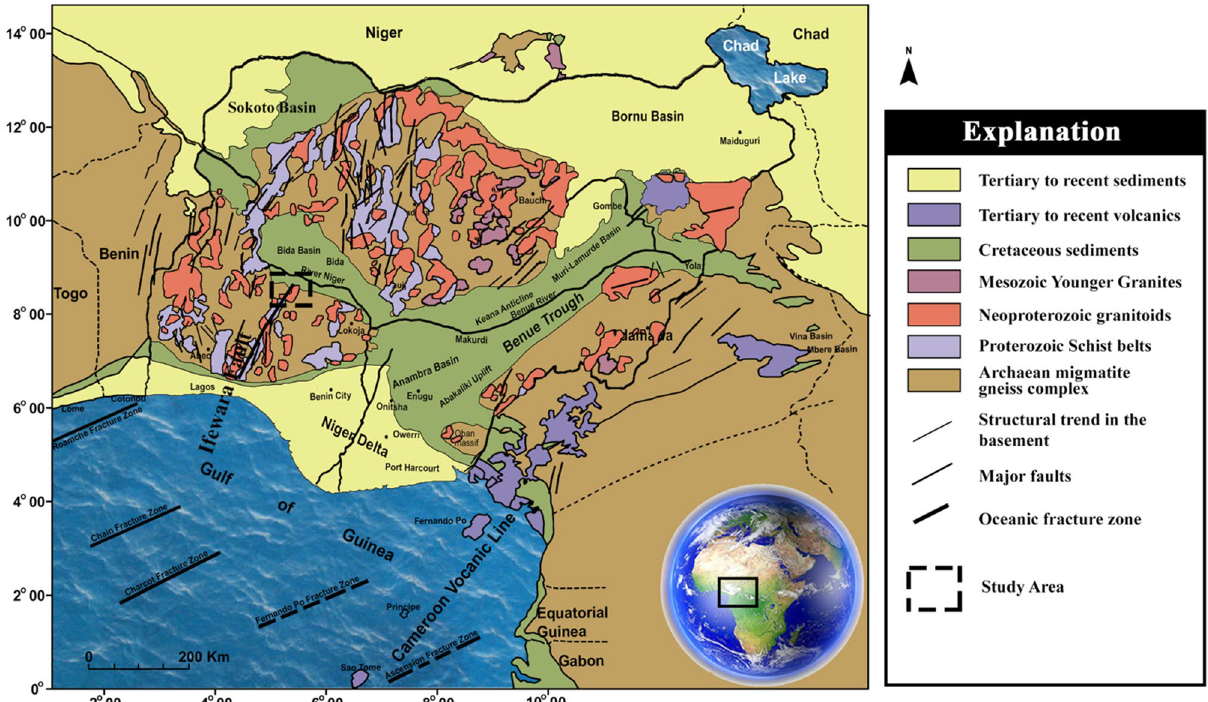
and remote sensing interpretation, Salawu et al. 15 [COPYRIGHT]